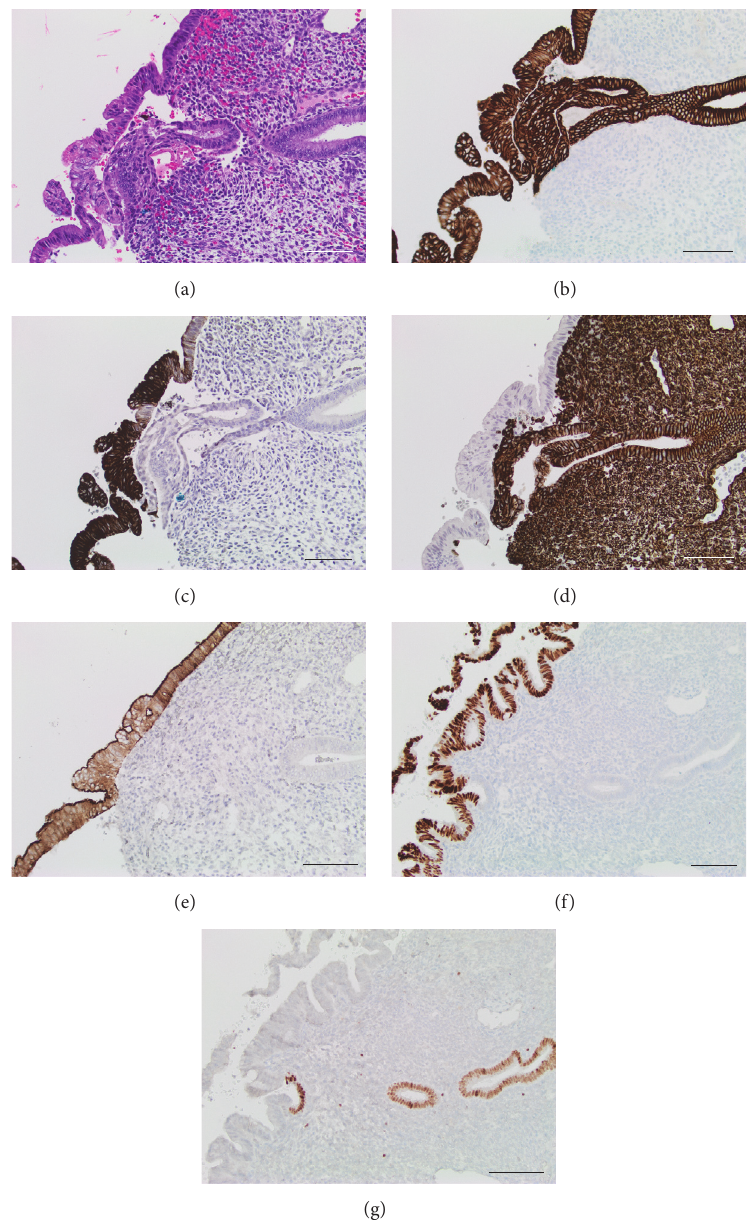
Figure 3: (a) High power view of the endometrium with the somewhat more eosinophilic neoplastic surface epithelium as compared to the underlying nonneoplastic endometrial glands; 20x, H&E, and scale bar = 100 micrometers. (b) Strong immunoreactivity for CK7 in both neoplastic surface epithelium and nonneoplastic endometrial glands; 20x and scale bar = 100 micrometers. (c) Strong immunoreactivity for CK20 in the neoplastic surface epithelium but not in nonneoplastic endometrial glands; 20x and scale bar = 100 micrometers. (d) Strong immunoreactivity for vimentin in nonneoplastic endometrial glands and stroma but not in neoplastic surface epithelium; 20x and scale bar = 100 micrometers. (e) Strong immunoreactivity for villin in the neoplastic surface epithelium but not in nonneoplastic endometrial glands; 20x and scale bar = 100 micrometers. (f) Strong immunoreactivity for Cdx-2 in the neoplastic surface epithelium but not in nonneoplastic endometrial glands; 20x and scale bar = 100 micrometers. (g) Strong immunoreactivity for Pax-8 in nonneoplastic endometrial glands but not in neoplastic surface epithelium; 20x and scale bar = 100